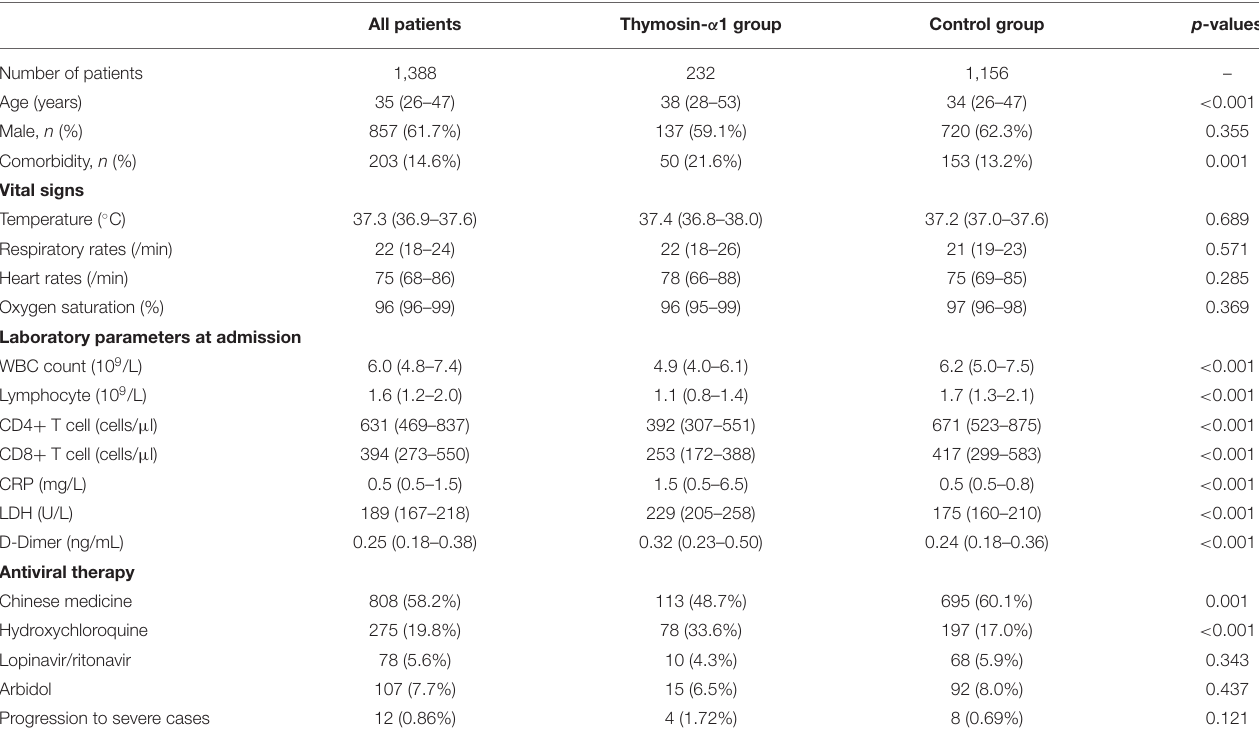
TABLE 1 | Baseline characteristics of